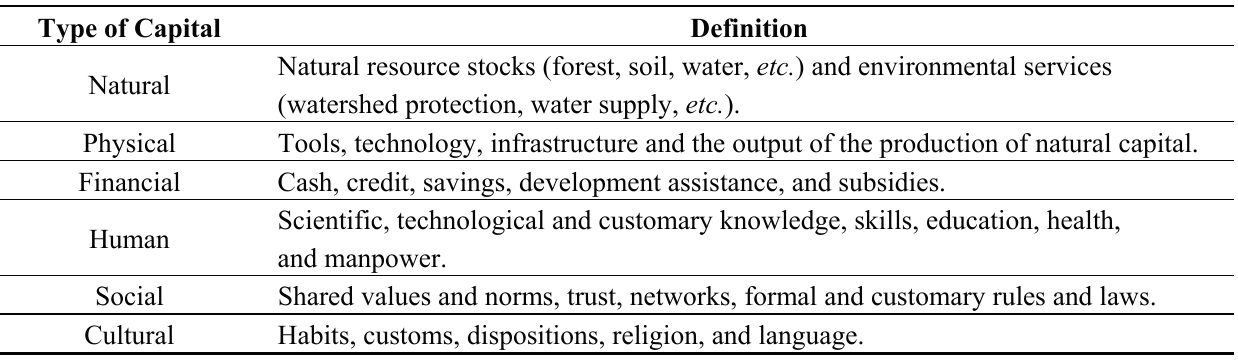
Table 1. Different types of capital. Sources: [15,18–20].